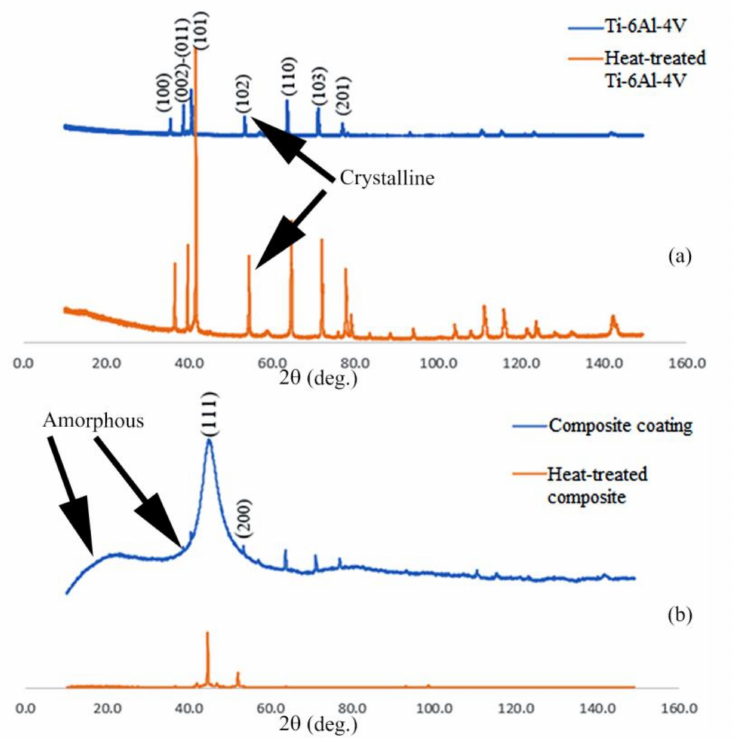
Figure 4. XRD patterns of ( a ) Ti-6Al-4V and ( b ) the coated sample, the blue lines show the non-heat- treated samples, while the oranges are for the heat-treated samples.